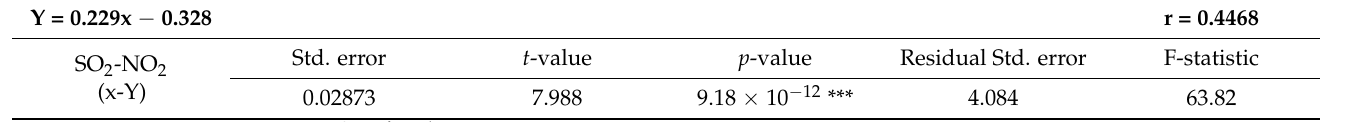
Table 3. Summary statistics from linear regression model for SO 2 and NO 2 .